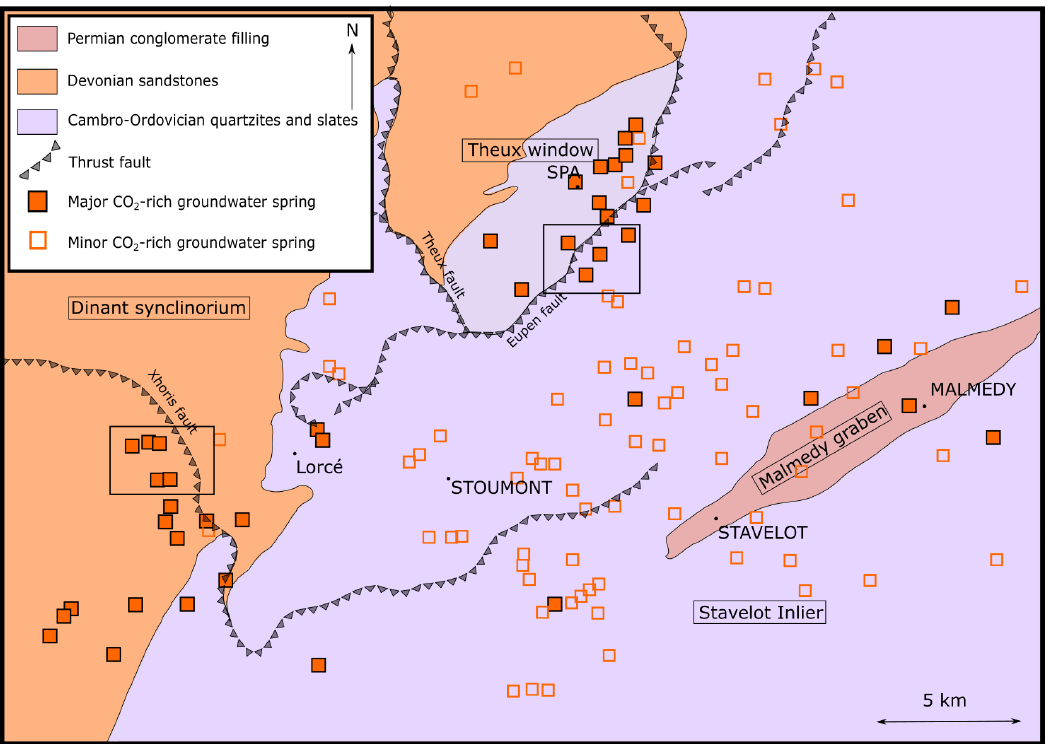
Figure 2. Location of the main CO 2 -rich and ferruginous springs in the studied part of the Stavelot Inlier. Major springs are regularly visited and analysed, whereas minor springs are simply recognised. The position of both study sites is indicated by the black rectangles (see Figures 4 and 5).